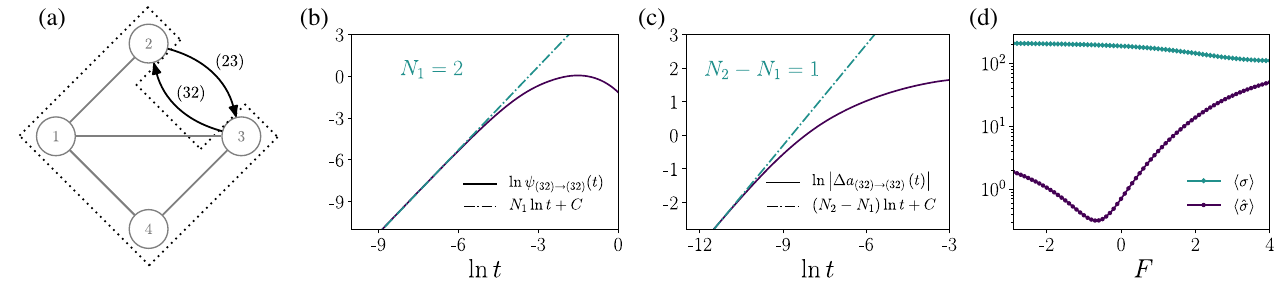
FIG. 4. Inference of cycle lengths and entropy estimation for a partially accessible two-cycle network. (a) Effective description of a four-state network with two cycles in which transitions along the link between states 2 and 3, i.e., (23) and (32), are observable. F is a dimensionless force applied to the observable link between states 2 and 3; all transition rates of the network are given in Appendix E. (b) Inference of the number of hidden transitions N 1 of the smallest network cycle C 0 based on waiting time distributions calculated with the method from Appendix A 3 for fixed F ¼ ln 3 . N 1 ¼ 2 corresponds to the slope of the short-time limit of ln ψ ð t Þ resulting in j C 0 j ¼ 3 . (c) Inference of the number of hidden transitions N 2 of the second-smallest network cycle C 1 based on waiting time distributions calculated with the method from Appendix A 3 for fixed F ¼ ln 3 . N 2 − N 1 ¼ 1 corresponds to the slope of the short-time limit of ln j Δ a ð t Þj resulting in N 2 ¼ 3 and j C 1 j ¼ 4 . (d) The estimator h ˆ σ i from Eq. (28) for the mean entropy production h σ i of the full network as a function of F . The details for the simulations of ν ð t Þ and ν − ð t Þ are given in Appendix E. The method from þjþ j − Appendix A 3 is used to calculate a ð t Þ